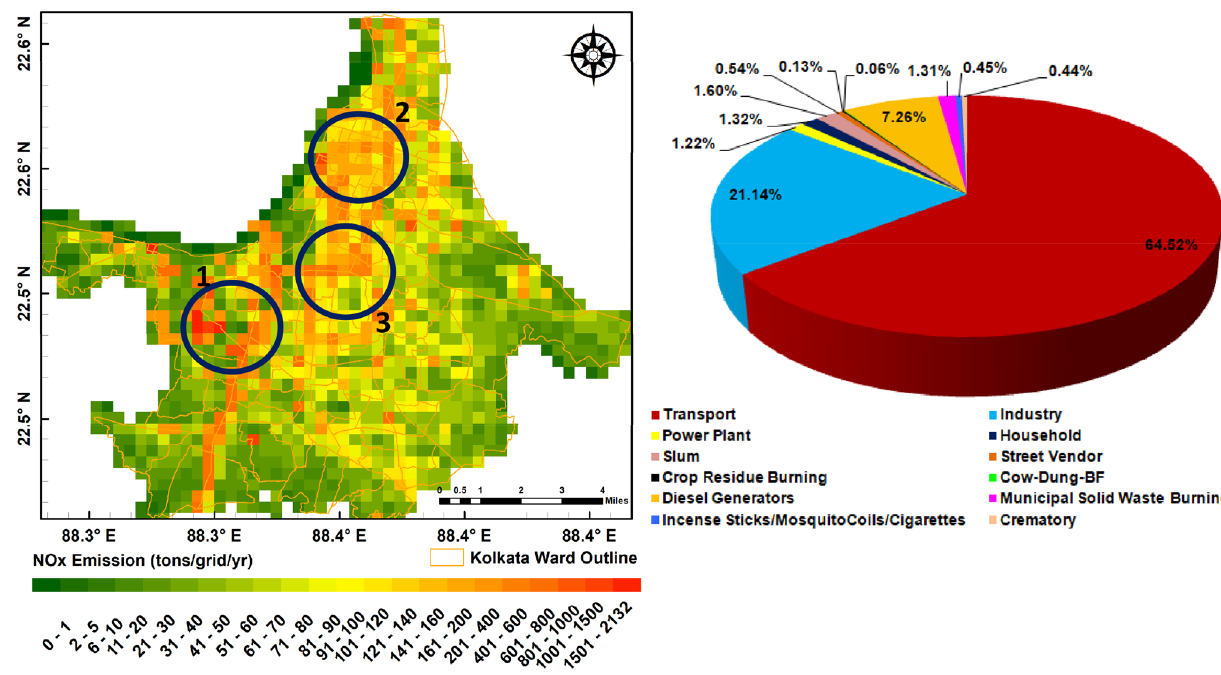
Fig. 5 Gridded annual NO